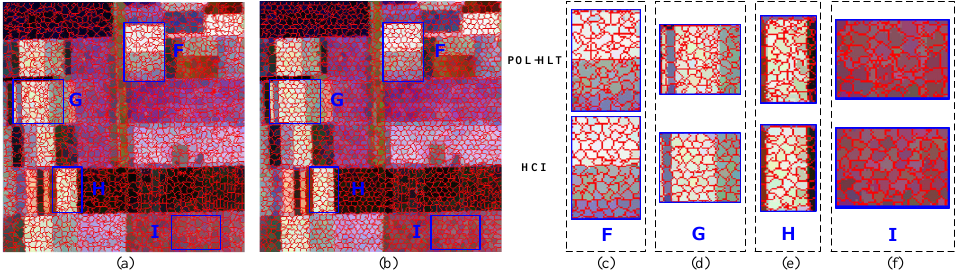
Figure 15. Generated superpixels of the region A of AIRSAR data set. ( a ) POL-HLT. ( b ) The proposed HCI. ( c ) Enlarged regions F. ( d ) Enlarged regions G. ( e ) Enlarged regions H. ( f ) Enlarged regions